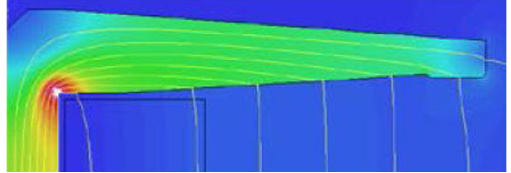
FIG. 8. Example of pole profile ( 1 = 4 of cross section shown) for a combined function magnet; in this case, the central slope is 4 deg, yielding a gradient of 86 mT = m for a field of 60 mT. The colorbar follows the same scale of Fig. 6.